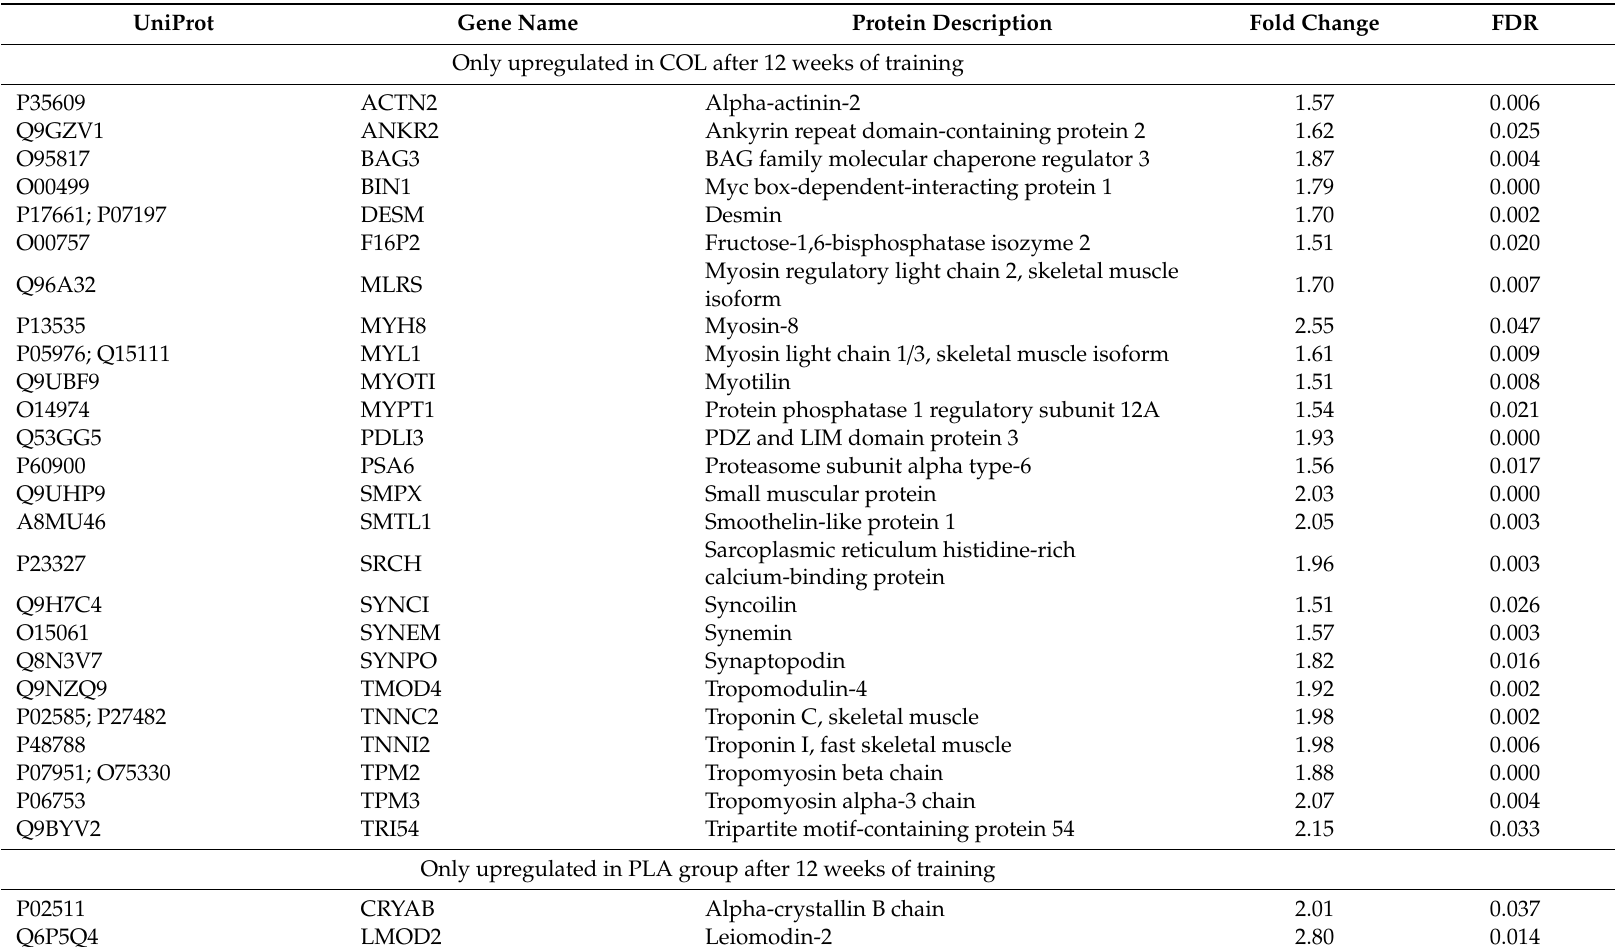
Table 5. Upregulated proteins belonging to the GO category “contractile fibers” in the collagen (COL) and placebo (PLA) groups.